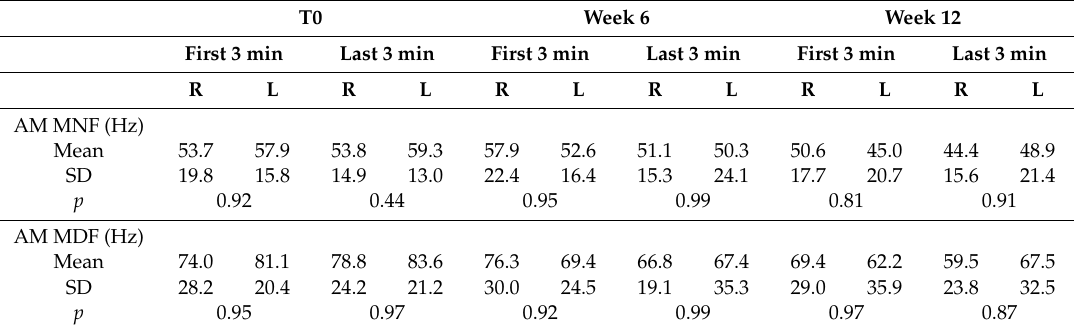
Table 8. MNF and MDF of AM muscle (in Hz) with respect to body side at each recording time (first 3 min and last 3 min of the session) and treatment time (T0: first session; 6w: week 6; 12w: week 12). Tukey multiple-comparison post-test p -values are reported.